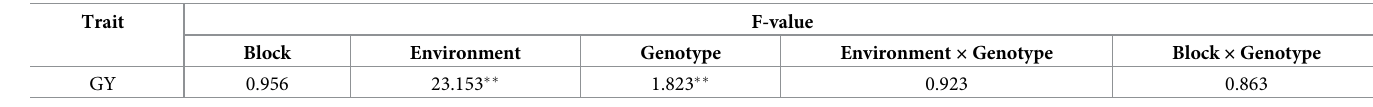
Kinship analysis of the 120 inbred lines was carried out in combination with 195 SSR markers using SPAGeDi-1.3d software. Results showed that 58% of the population had no relationship for relative kinship value (K) equaling to 0 and only 6% of the materials had high kinship with K > 0.5 (Fig 2). Table 2. Analysis of variance for